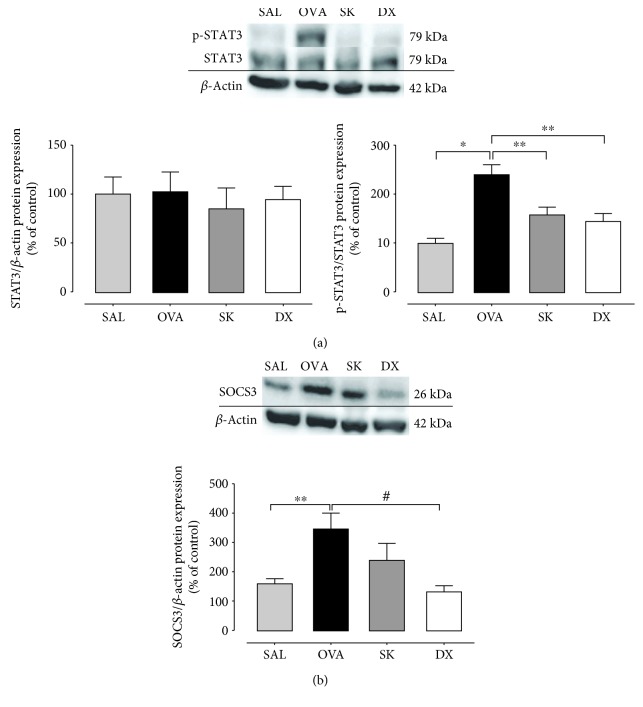
Sakuranetin inhibits the activation of the STAT3-SOCS3 pathway. Expression and intensity of (a) STAT3 and p-STAT3 and (b) SOCS3 in lung tissue detected by immunoblotting. Sakuranetin reduced the phosphorylation of STAT3 that was enhanced in the asthmatic group. ∗p < 0.001, ∗∗p < 0.01, and #p < 0.05. Data represent mean ± SEM from 5 to 8 mice per group.